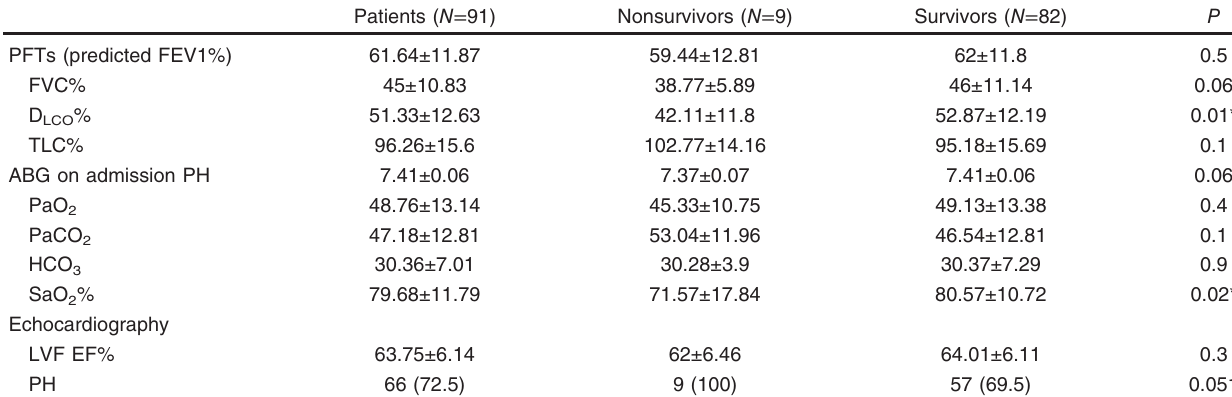
Table 3 Comparison between survivors and nonsurvivors as regards pulmonary functions, arterial blood gases, and echocardiography